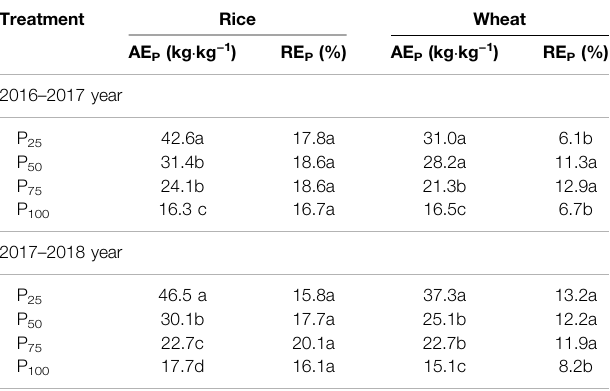
TABLE 9 | Effect of optimized fertilization on P use ef fi